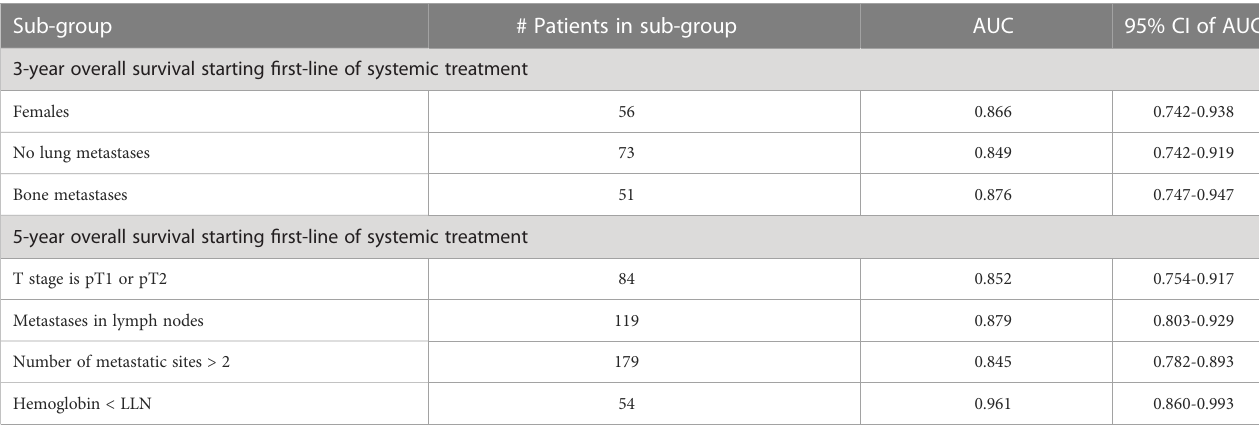
TABLE 5 Subgroup analysis - performance of the ensemble model in selected subgroups for three- and fi ve-year overall survival.